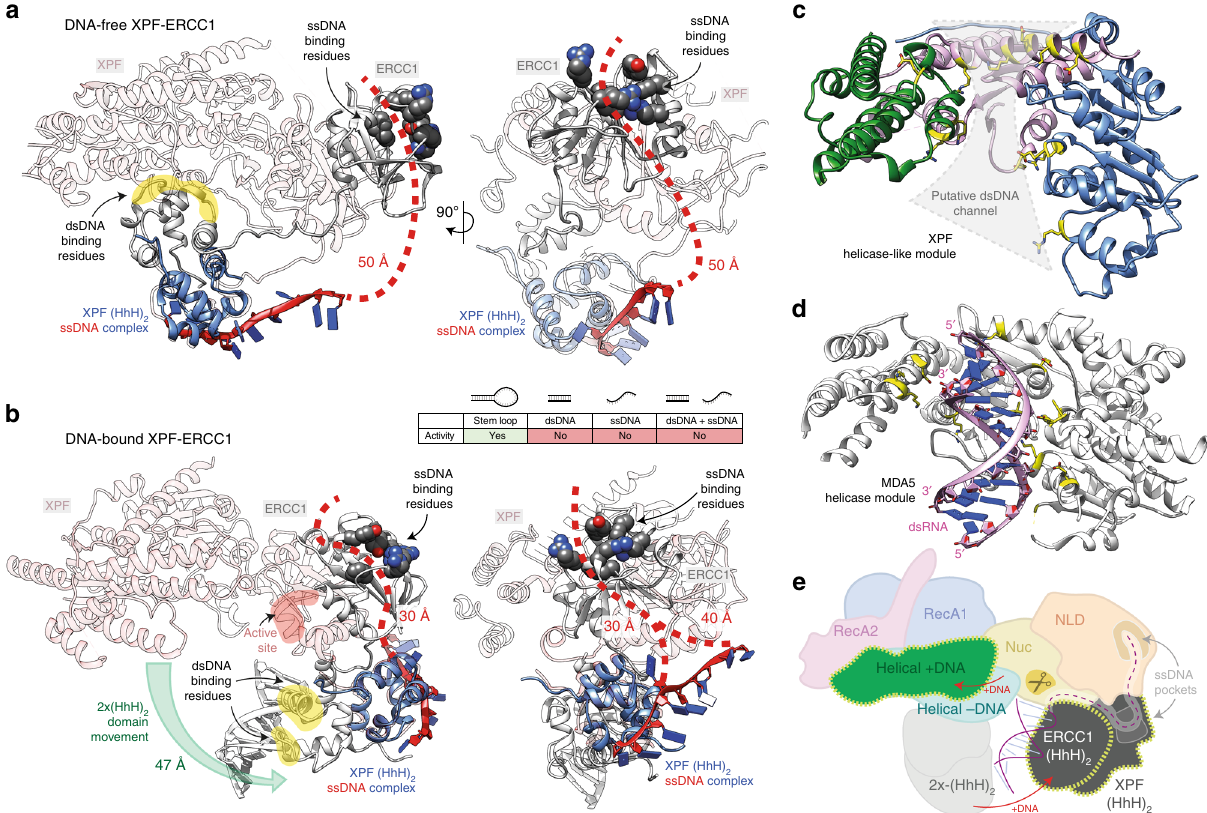
Fig. 5 Comparison of DNA-free and DNA-bound XPF – ERCC1 gives insights into DNA-junction activation. a Two orthogonal views of DNA-free XPF – ERCC1 highlighting known ssDNA binding sites. An NMR structure of XPF (HhH) 2 domain bound to a ssDNA (PDB: 2KN7) mapped on to the full- length DNA-free structure indicates a distance of ~50Å between the ssDNA-binding site and residues known to bind ssDNA in the ERCC1 NLD. b Equivalent views as in panel a for DNA-bound XPF – ERCC1 indicating the 2×(HhH) 2 domain undergoes a substantial movement to engage the ERCC1 NLD. This positions the two ssDNA-binding sites close enough to simultaneously engage ssDNA. Inset shows only a stem loop is a substrate for XPF- ERCC1. c The XPF HLM from the DNA-bound structure contains a concave surface lines with basic residues (yellow) that could potentially bind to dsDNA. d Equivalent view to panel c of the helicase module from MDA5 bound to A-form dsRNA (PDB: 4GL2) through an equivalent positively charged concave surface. e Proposed model for XPF – ERCC1 domain rearrangements upon binding stem – loop DNA. Red arrows indicate direction of domain rearrangements from DNA-free to DNA-bound. Dotted yellow lines indicate domains that undergo signi fi cant conformational changes. Scissors indicate the approximate location of the active